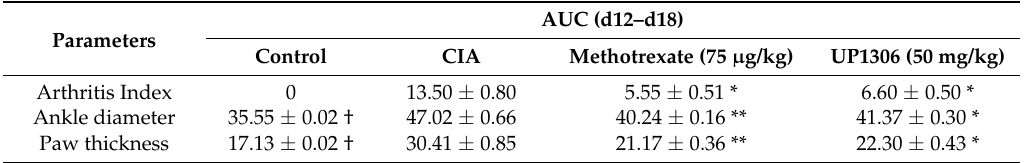
Table 1. Area under treatment curve for collagen-induced arthritis (CIA) rats treated with UP1306 and Methotrexate.